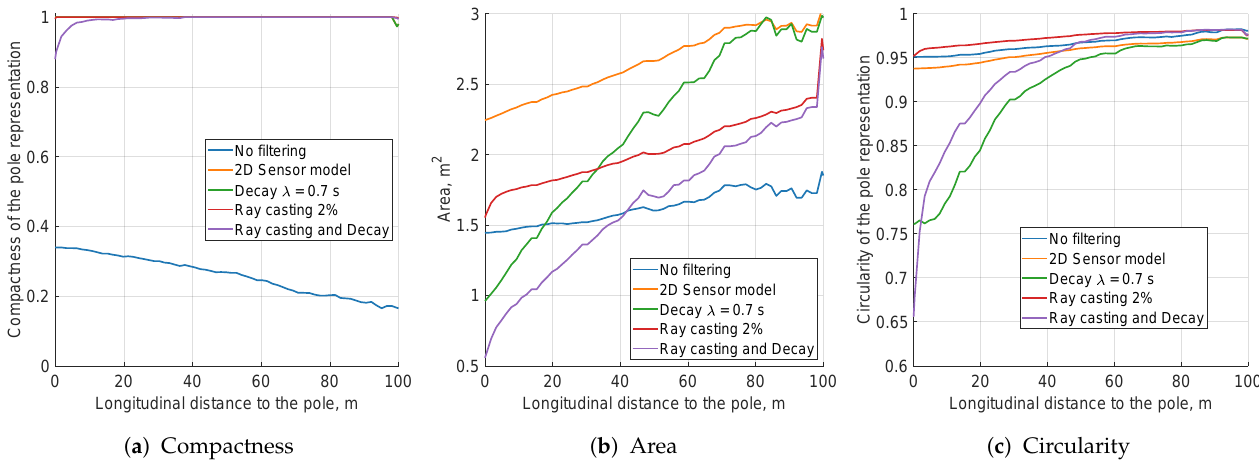
Figure 16. The key performance indicators computed for the simulation data for different variants.